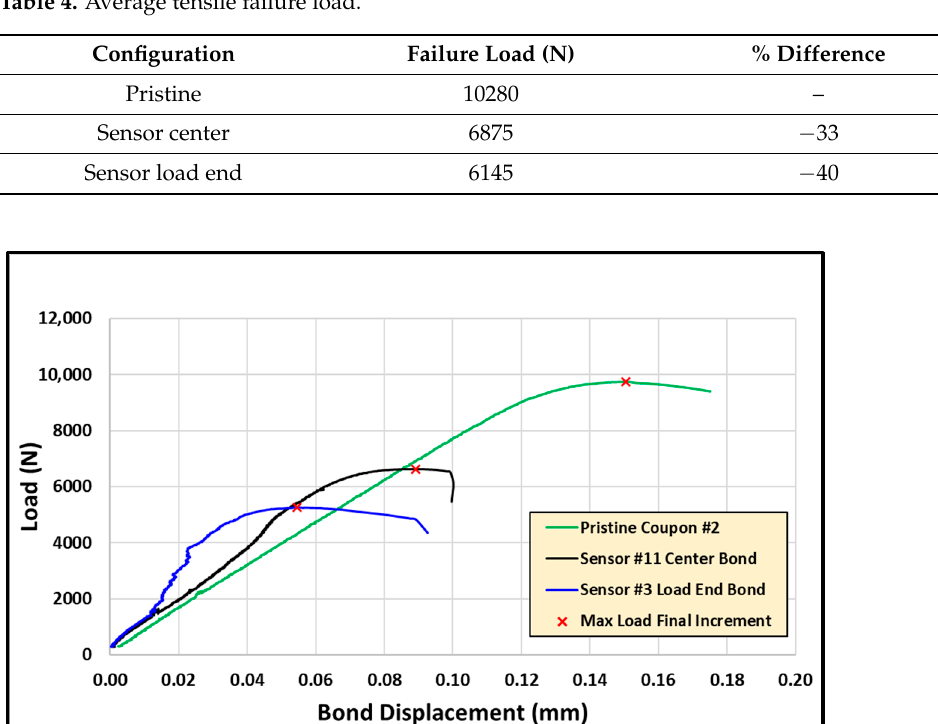
Figure 22. Free versus embedded sensor average impedance.